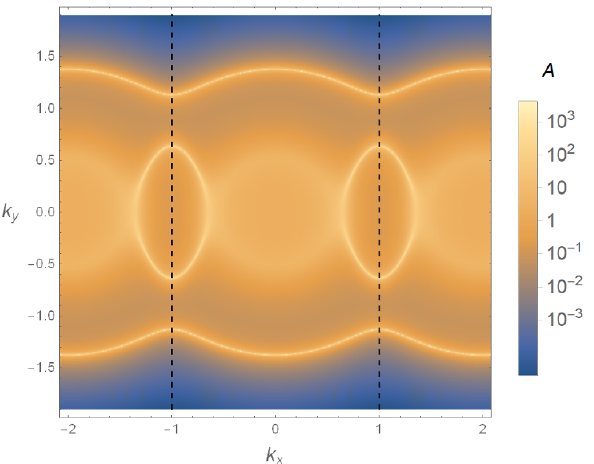
Figure 9 . The density plot of A in the ( k x ; k y ) plane after turning on the ionic lattice for (cid:12)xed ! = 10 (cid:0) 6 , q = 2. The brightest points correspond to the location of the Fermi surface. We have adopted a logarithmic scale and periodically extended the data from the (cid:12)rst Brillouin zone to the other zones. This case corresponds to the PDW phase shown in (cid:12)gure 2 with T = 0 : 01426, a 0 = 0 : 5, p = 2. Note that the vertical axis is logarithmic. The (cid:12)rst Brillouin zone boundary is indicated by two vertical dashed lines located at k x = (cid:6) 1.